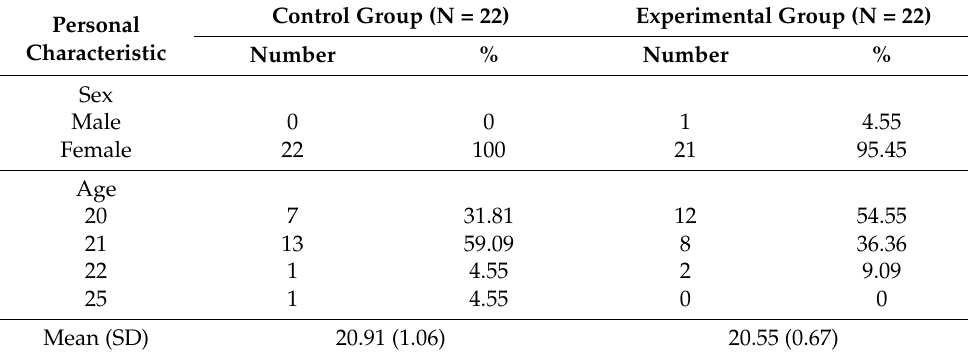
Table 2. Basic information of participating nursing students (N =